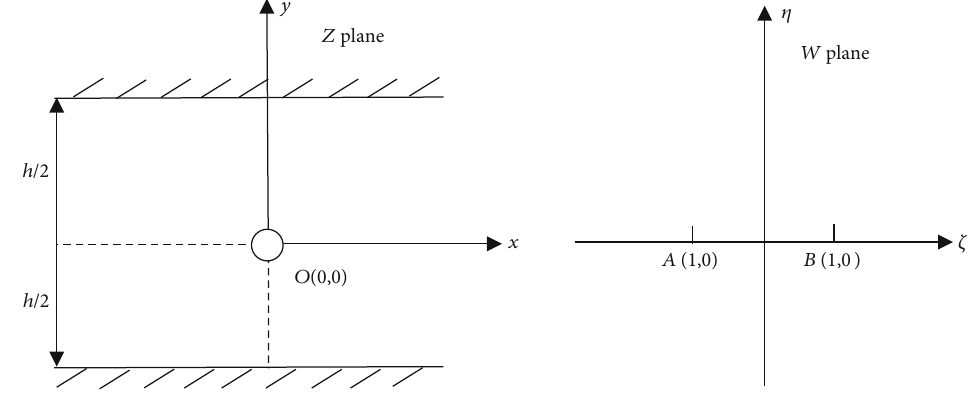
Figure 3: Correspondence diagram of conformal transformation.